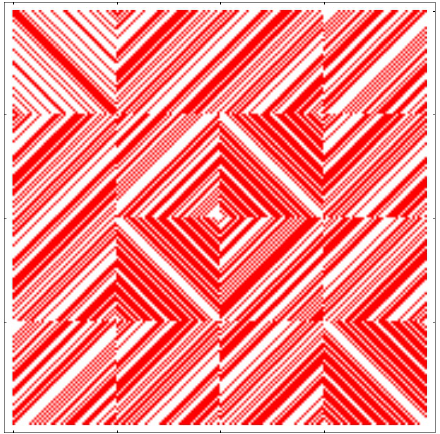
Figure 3: A visualization of the single solution found of order 4 · 43 =